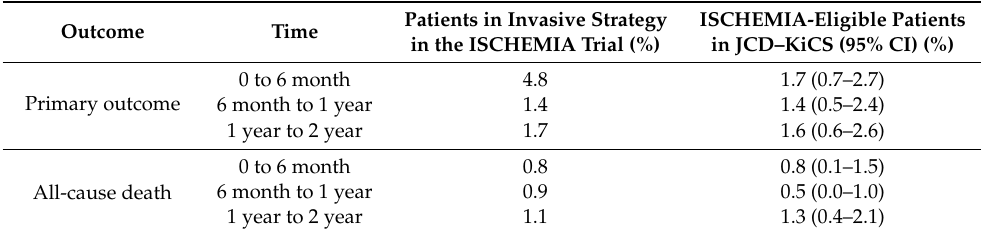
Table 2. Long-term outcomes of the actual ISCHEMIA participants and the ISCHEMIA-eligible patients in